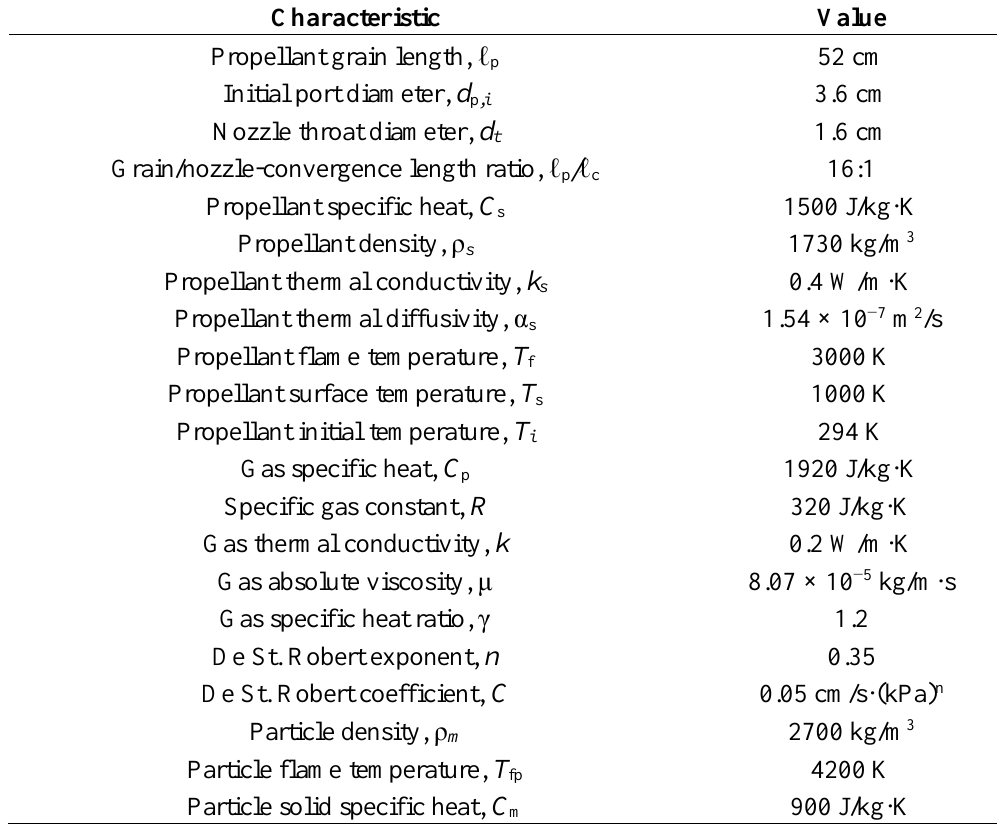
Table 1. Reference motor